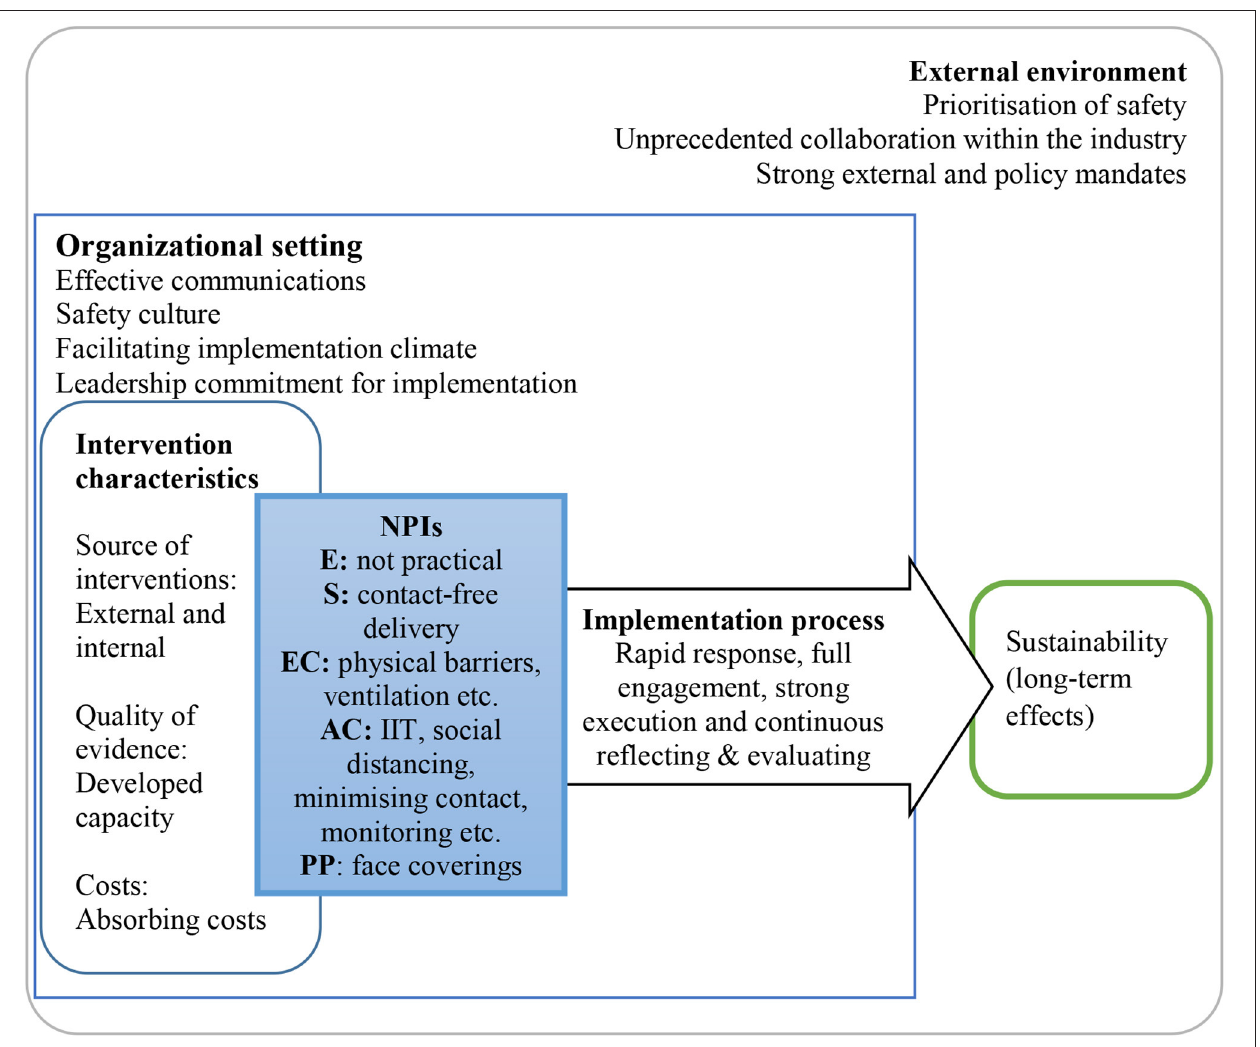
FIGURE 2 | Qualitative evaluation of non-pharmaceutical interventions in non-healthcare sector: an example of the UK logistics sector during COVID-19